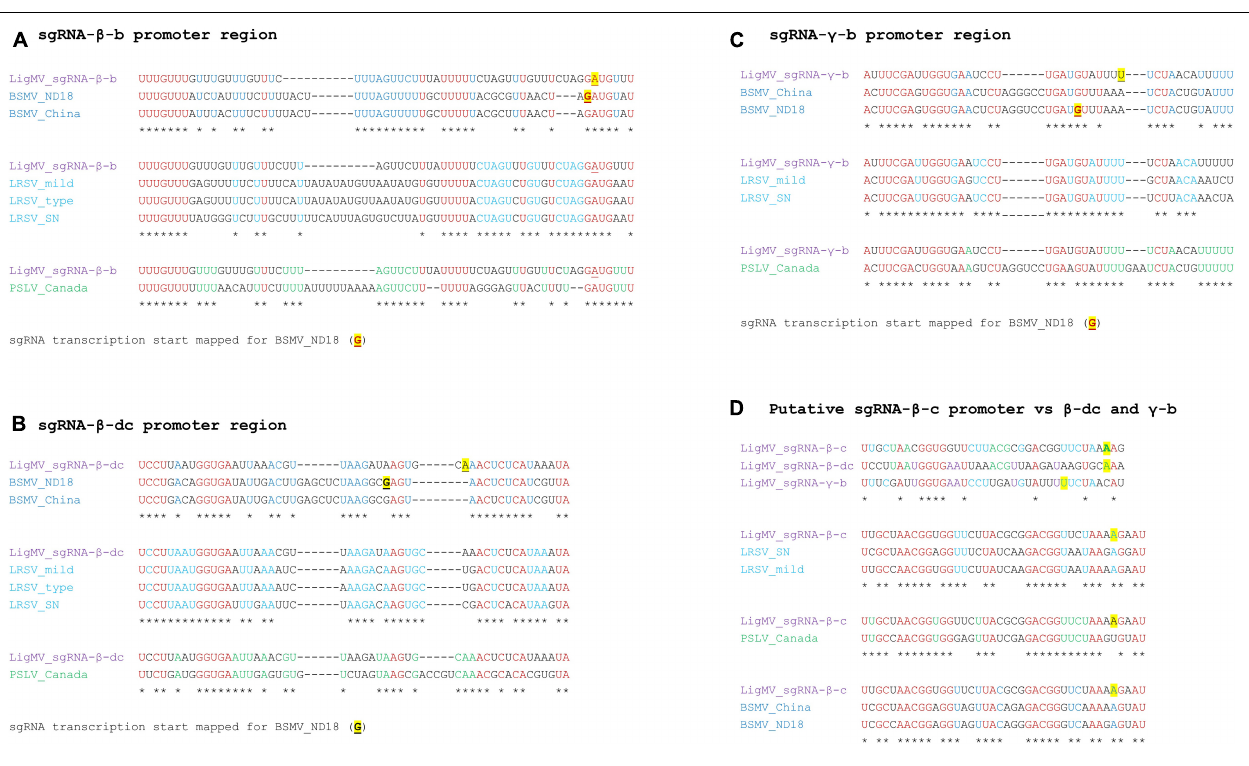
FIGURE 5 | Sequence analysis of ligustrum mosaic virus (LigMV) subgenomic RNA (sgRNA) promoters. The sequences preceding predicted transcription start sites of the sgRNAs β -b (A) , β -dc (B), and γ -b (C) and the putative sgRNA- β -c (D) were compared with the respective sequences from barley stripe mosaic virus (BSMV) isolates ND18 (NCBI accession: U35770) and China (AY789694), lychnis ringspot virus (LRSV) isolates SN (MG913810), mild (MF768254) and type (NC_038932), and poa semilatent virus (PSLV) isolate Canada (MK377387). The nucleotides identical in all the viral species and isolates are shown in red. The nucleotides identical between LigMV and both BSMV isolates are shown in blue. The nucleotides identical between LigMV and all the LRSV isolates are shown in cyan. The nucleotides identical between LigMV and PSLV are shown in green. Consensus nucleotides are indicated by asterisks. The sgRNA transcription start sites mapped for the BSMV isolate ND18 (Zhou and Jackson, 1996b) are underlined and highlighted in yellow. The predicted start sites for LigMV sgRNAs are highlighted in